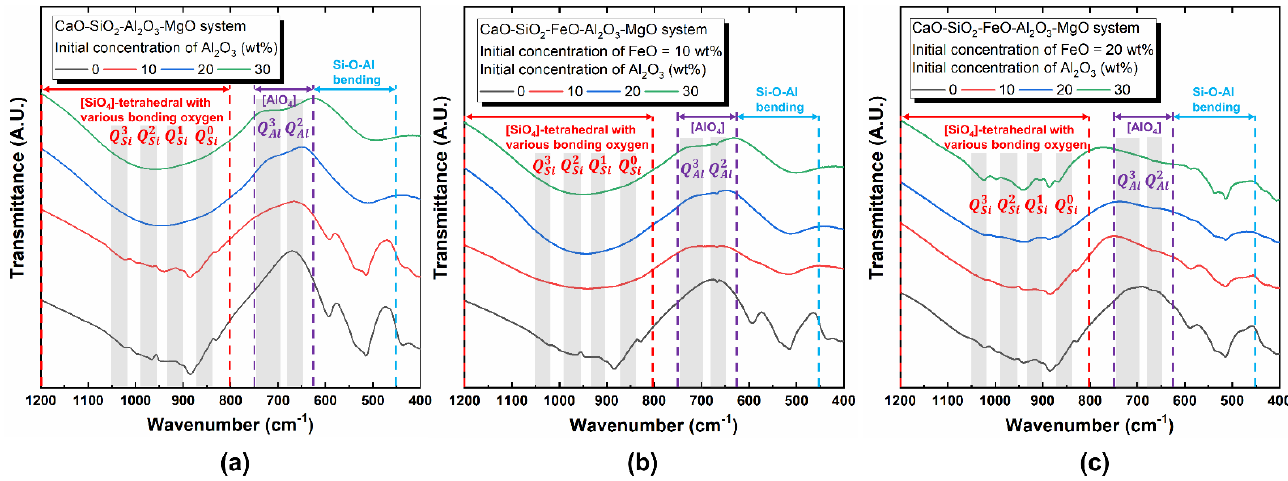
Figure 5. FT-IR transmittance spectra of quenched CaO–SiO 2 –FeO–Al 2 O 3 –MgO slag with varying Al 2 O 3 concentration for FeO contents of ( a ) 0 wt%, ( b ) 10 wt%, and ( c ) 20 wt%.